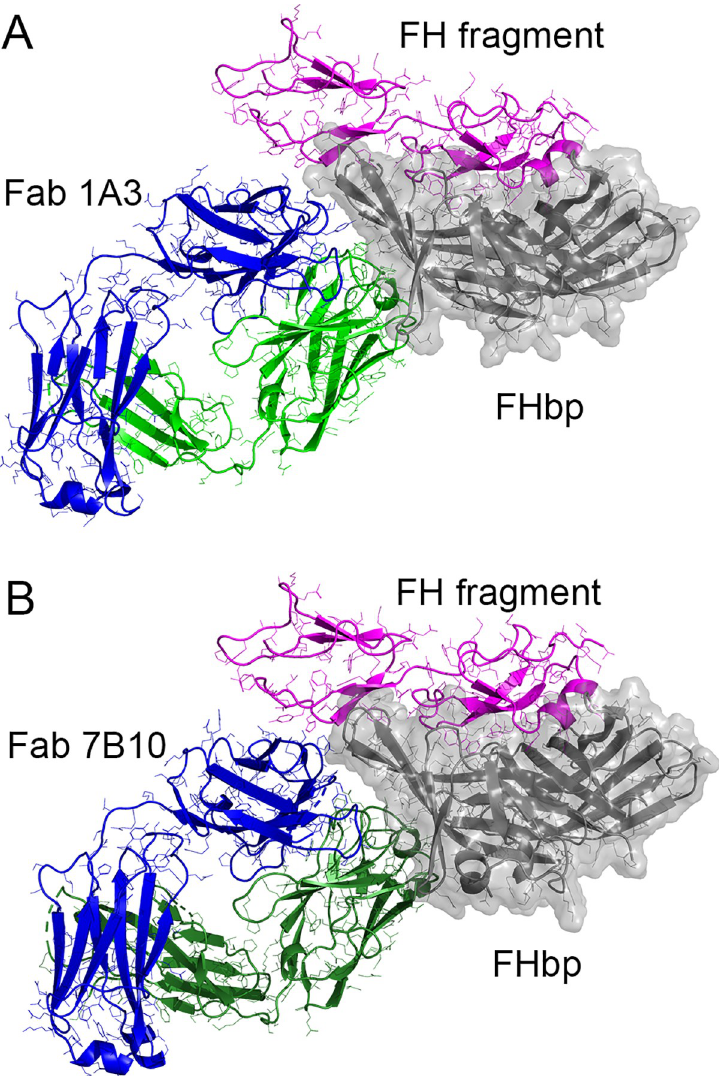
Fig 5. Molecular models showing relative positions of human Fabs and FH. (A) FHbp-Fab 1A3 complex superimposed with FHbp-FH complex PDB ID 2W80 [27]. (B) FHbp-Fab 7B10 complex superimposed with FHbp-FH complex. The coloring scheme and orientation is the same as in Fig 3, and human FH fragment (domains 6 and 7) are shown in magenta. Figure constructed using PyMol (Schrodinger, LLC).